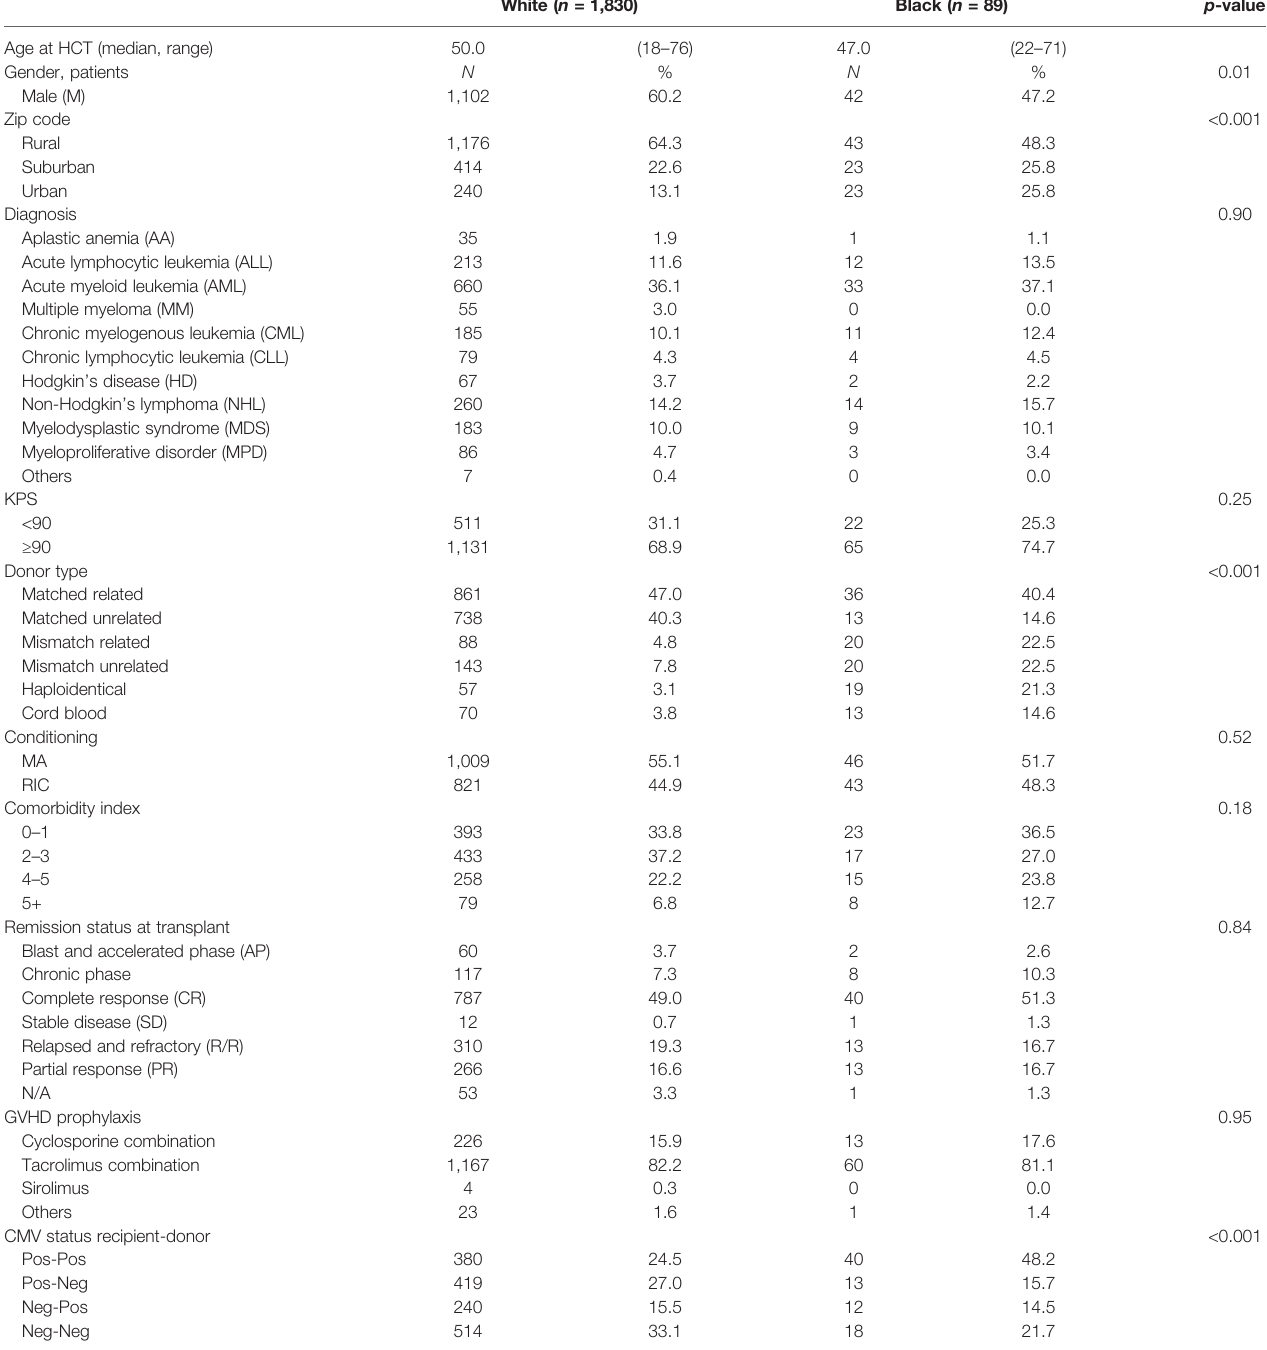
TABLE 1 | Patient characteristics by race. White ( n = 1,830) Black ( n = 89) p -value Age at HCT (median, range)